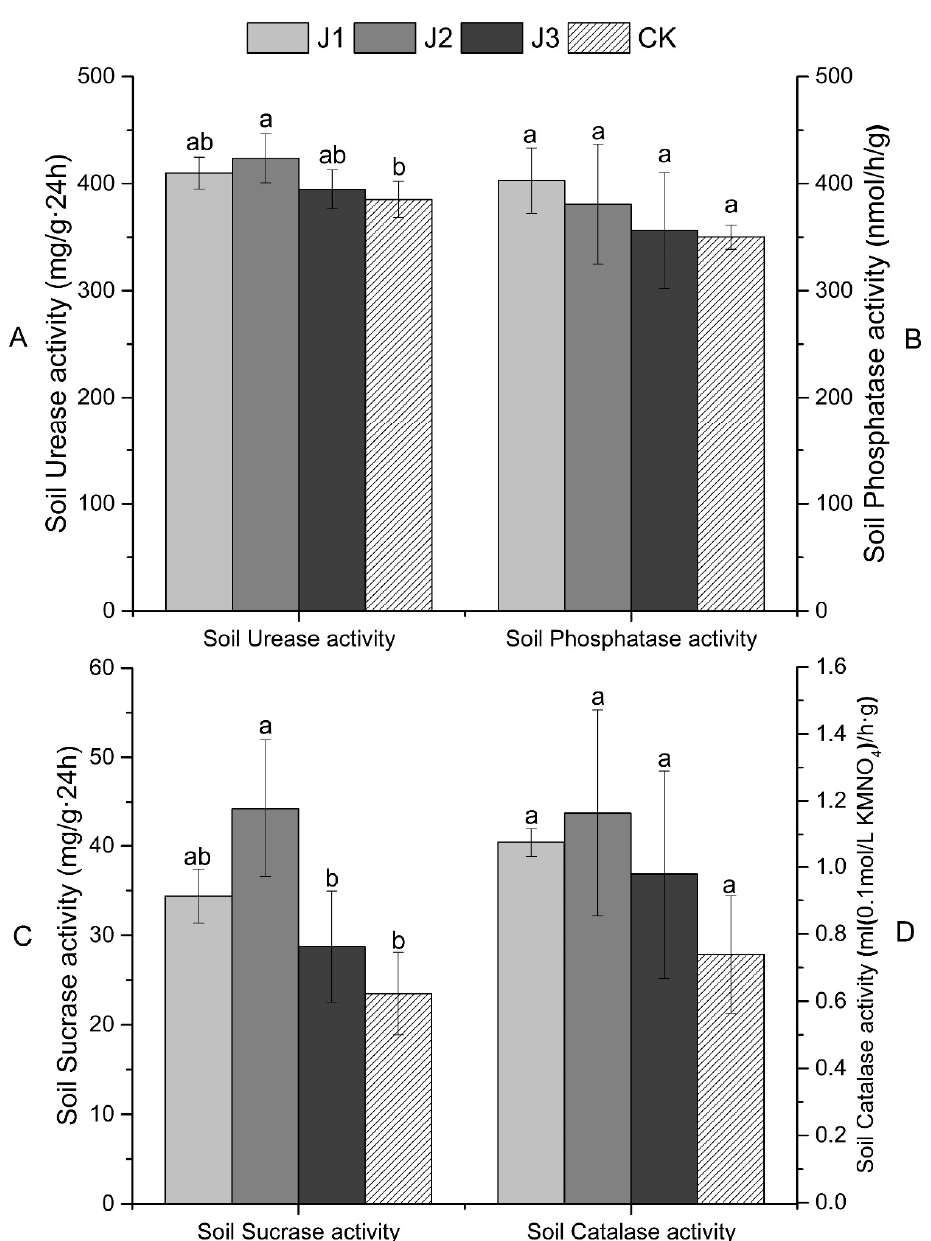
Figure 4. The responses of soil enzyme activities in the rhizosphere of R. pseudoacacia to applications of mineral-solubilizing microorganisms. Error bars are standard errors of the mean ( n = 3). ( A – D ) Different letters indicate significant differences ( p < 0.05) among the different treatments following a Duncan’s test. Experimental treatments: J1, NL-11; J2, NL-11 + NL-15; J3, NL-1 + NL-11 + NL-15.